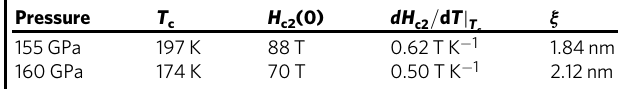
Table 1 Sample properties and results of WHH fi